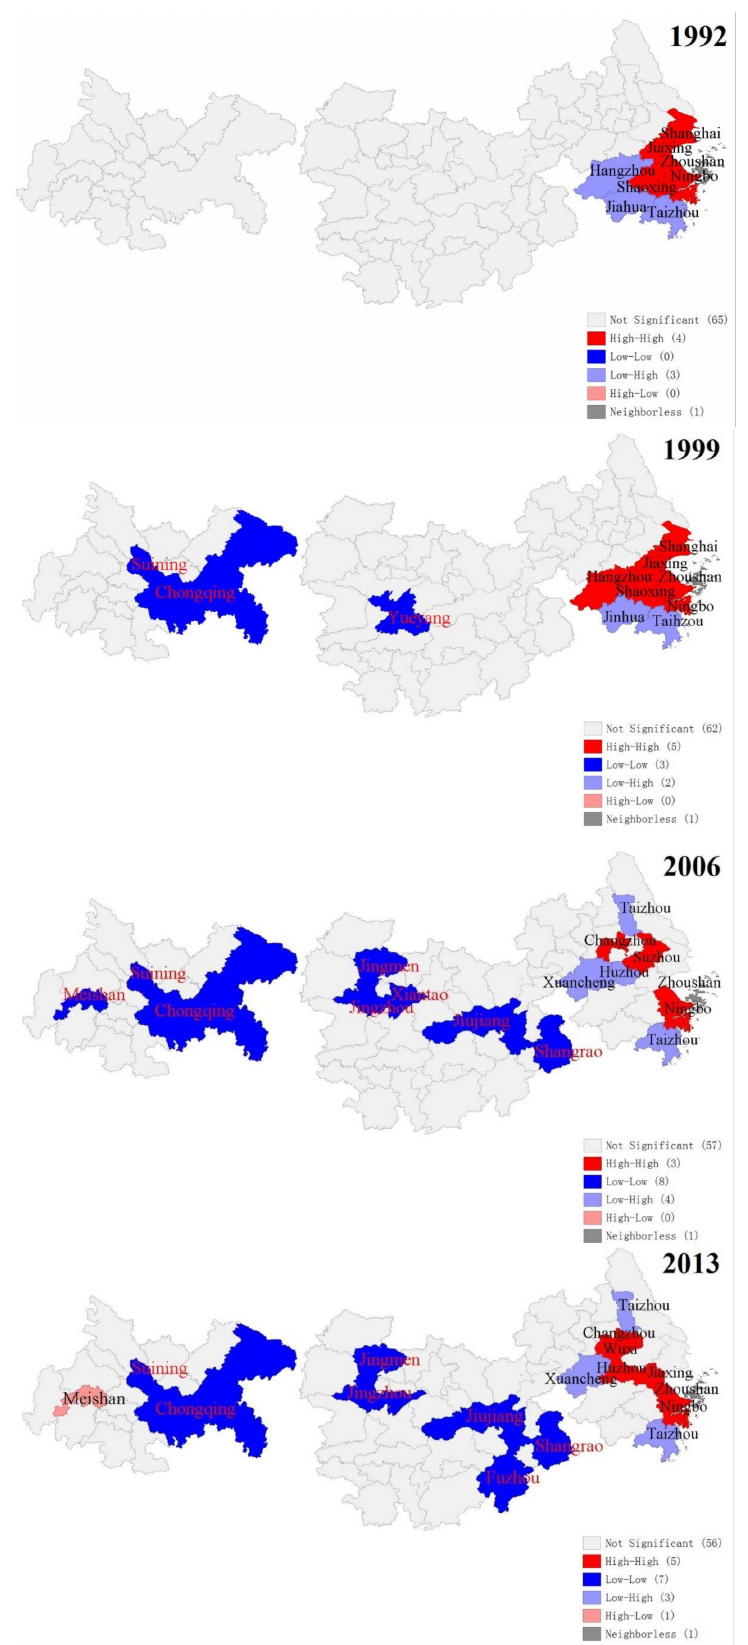
Figure 15. The LISA cluster map of the EPC of YREB’s three major urban agglomerations in 1992–